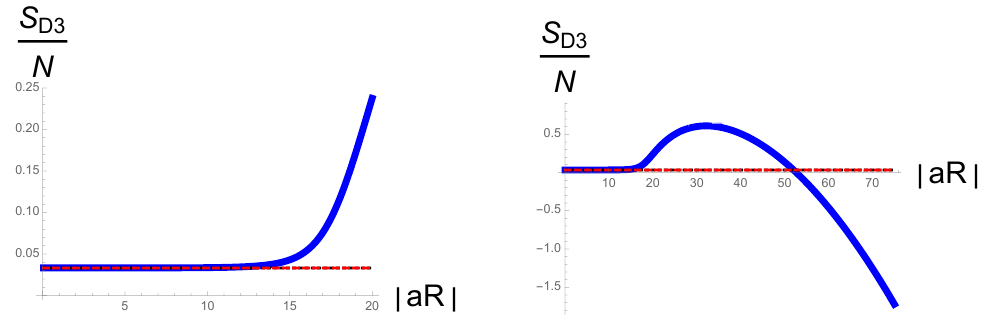
Figure 9 . The entanglement entropy for a < 0 solutions with ~ (cid:20) = 0 : 05. At low values of j a j R it tracks the result for k quarks, departing from it near j a j R (cid:25) 1 = ~ (cid:20) , and (cid:12)nally scaling as (cid:24) (cid:0) Na 2 for large enough a